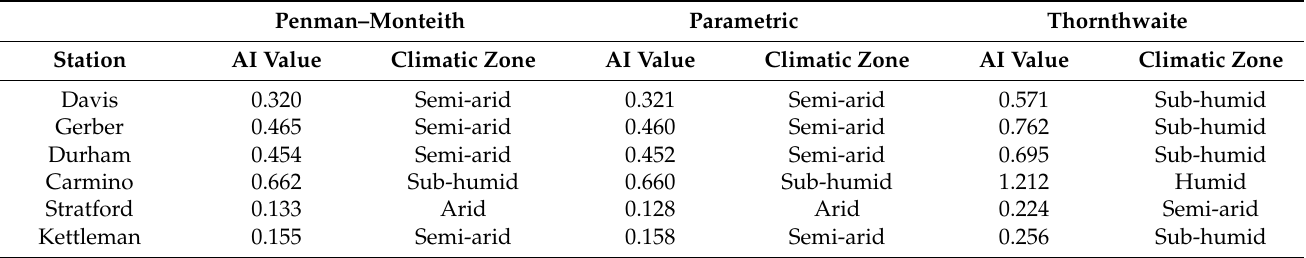
Table 5. Uncertainties in climate zone characterization due to the PET